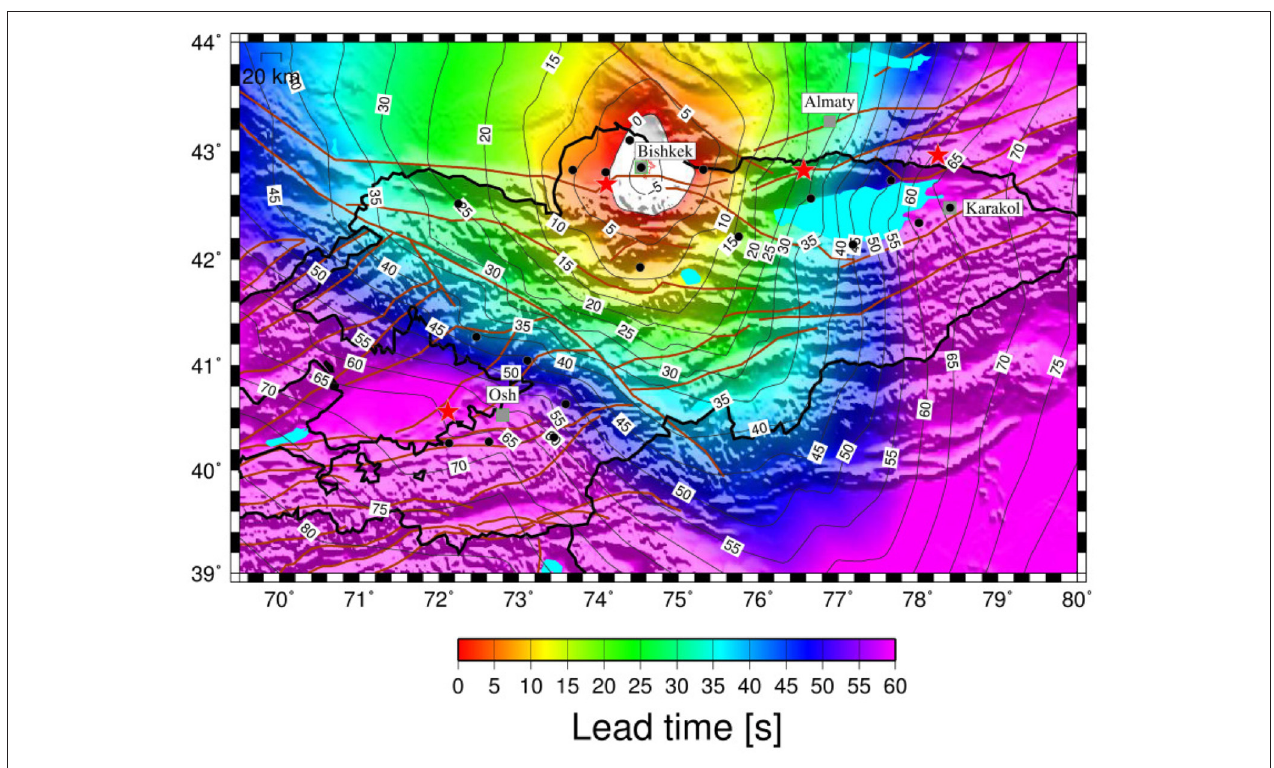
FIGURE 5 | The lead-times for Bishkek when using a regional approach as a function of the location of possible seismic events (i.e., a 0.1 by 0.1 ◦ grid). Also shown are the main cities (gray squares) and a selection of historical or hypothetical earthquakes (red stars, see Figure 1 and text for explanation). The brown lines indicate the main tectonic alignments and faults existing in the